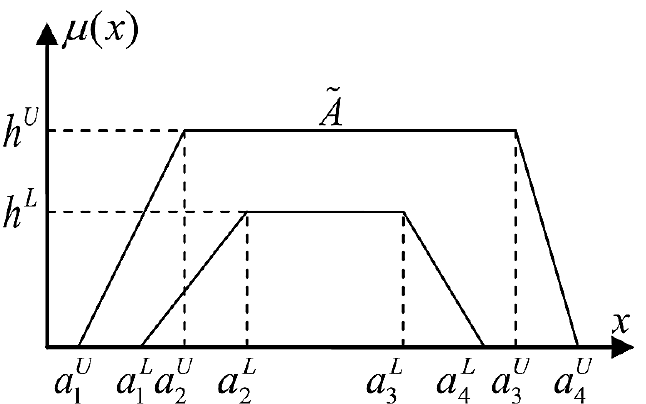
Figure 2. Membership function of the type-2 fuzzy system’s